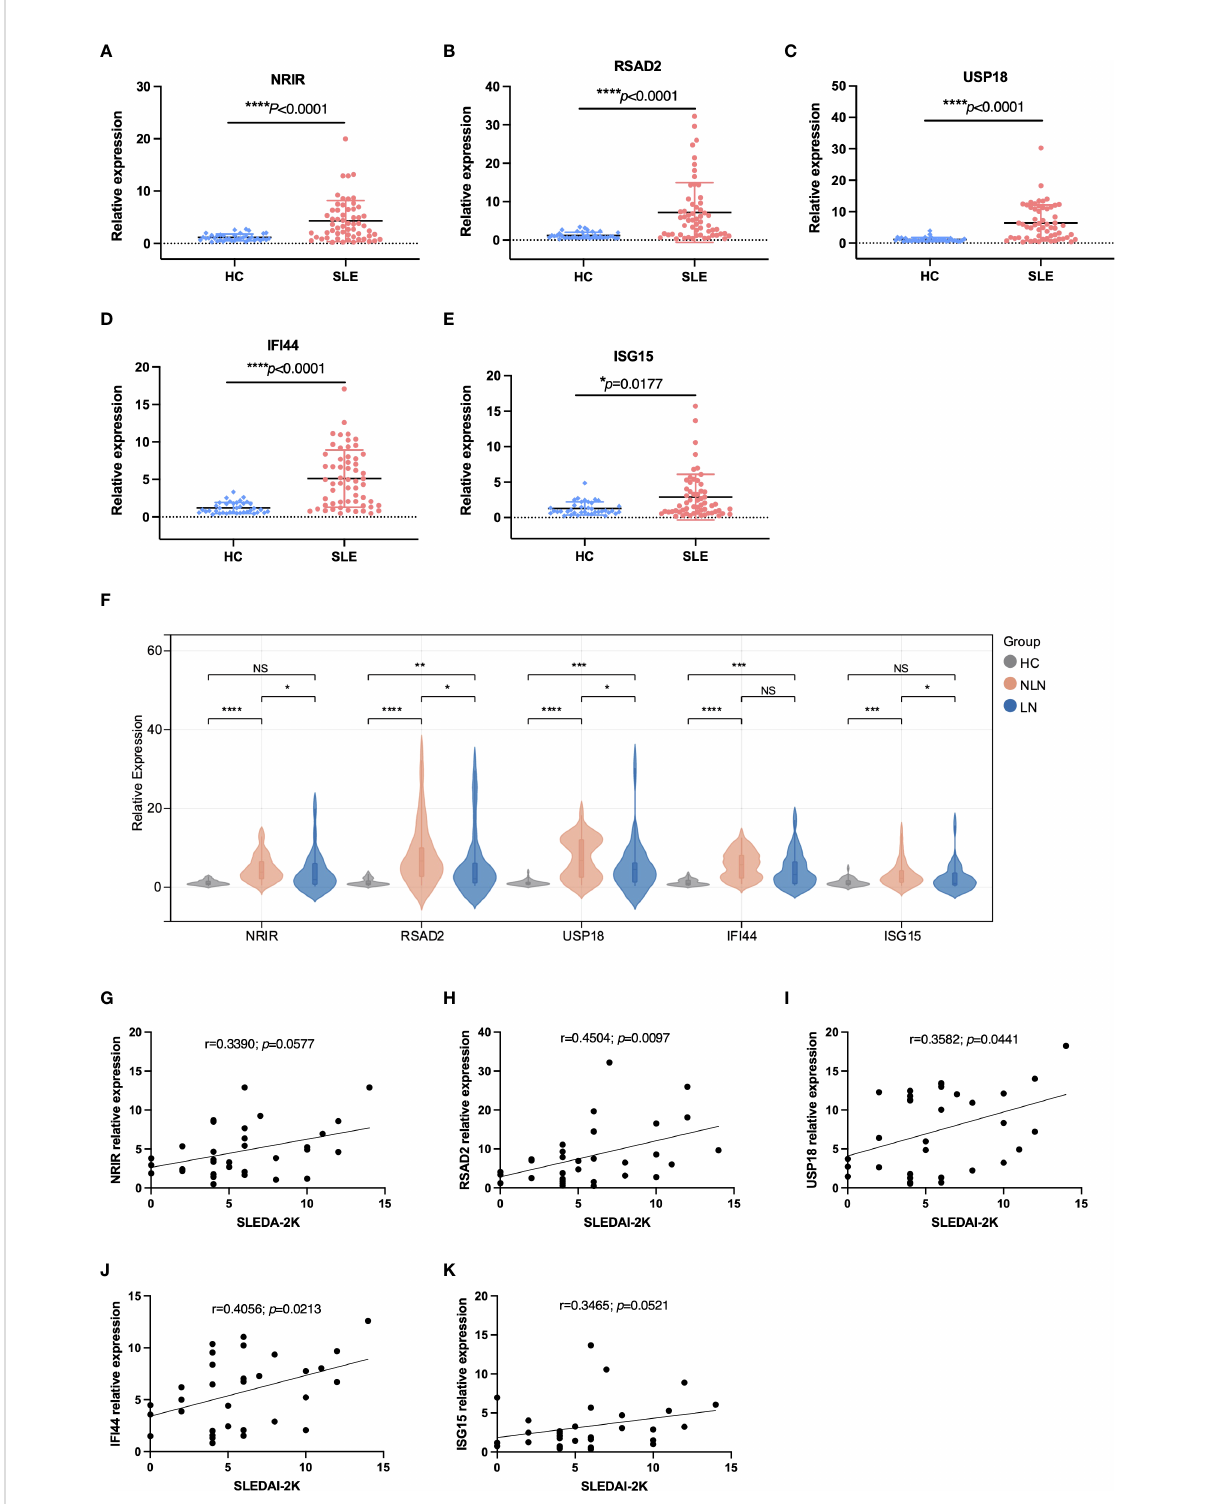
FIGURE 4 The RT-qPCR results of the validation study for the selected ISGs. (A-E) 5 ISGs were signi fi cantly differentially expressed between the HC and SLE group. (F) 5 ISGs were differentially expressed among the HC, NLN, and LN groups. (G-K) The correlations between ISGs relative expressions and SLEDAI-2K scores in the LN group. LN: SLE patients with lupus nephritis; NLN: non-lupus nephritis SLE patients. * P < 0.05, ** P < 0.01, *** P < 0.001, **** P < 0.0001, NS no signi fi cance (P ≥